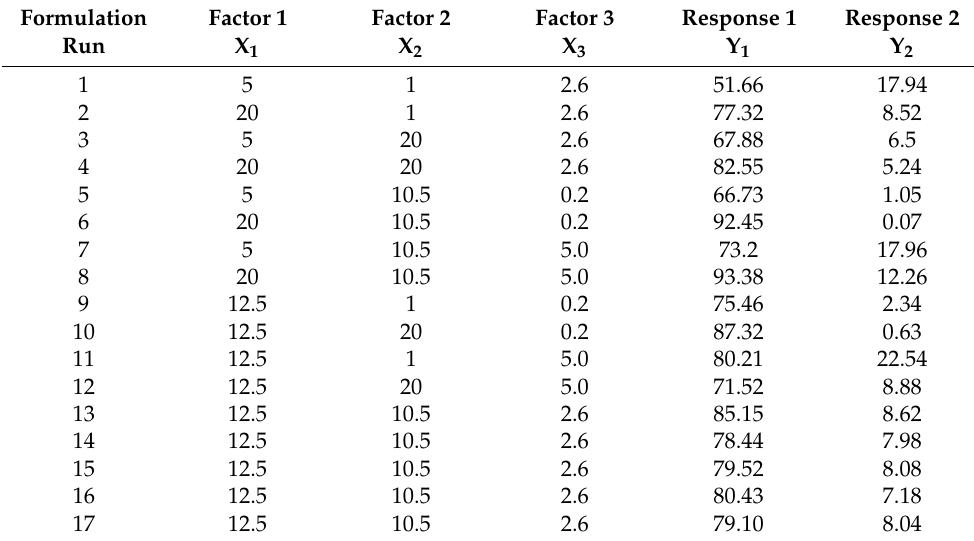
Table 3. Experimental runs and results of responses for